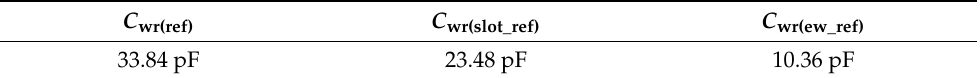
Table 2. Summary of the values of the components of C wr(ref) capacitance: C wr(slot_ref) and C wr(ew_ref)